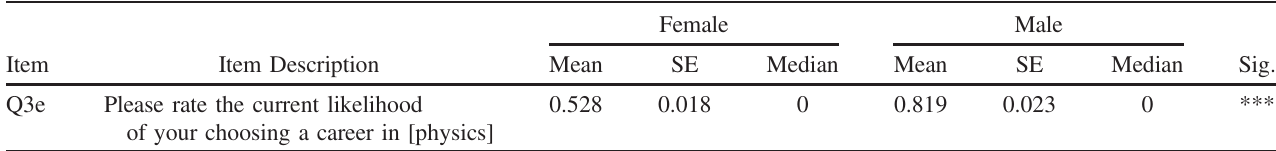
TABLE III. Wilcoxon test for physics career item. ***: p < 0 . 001